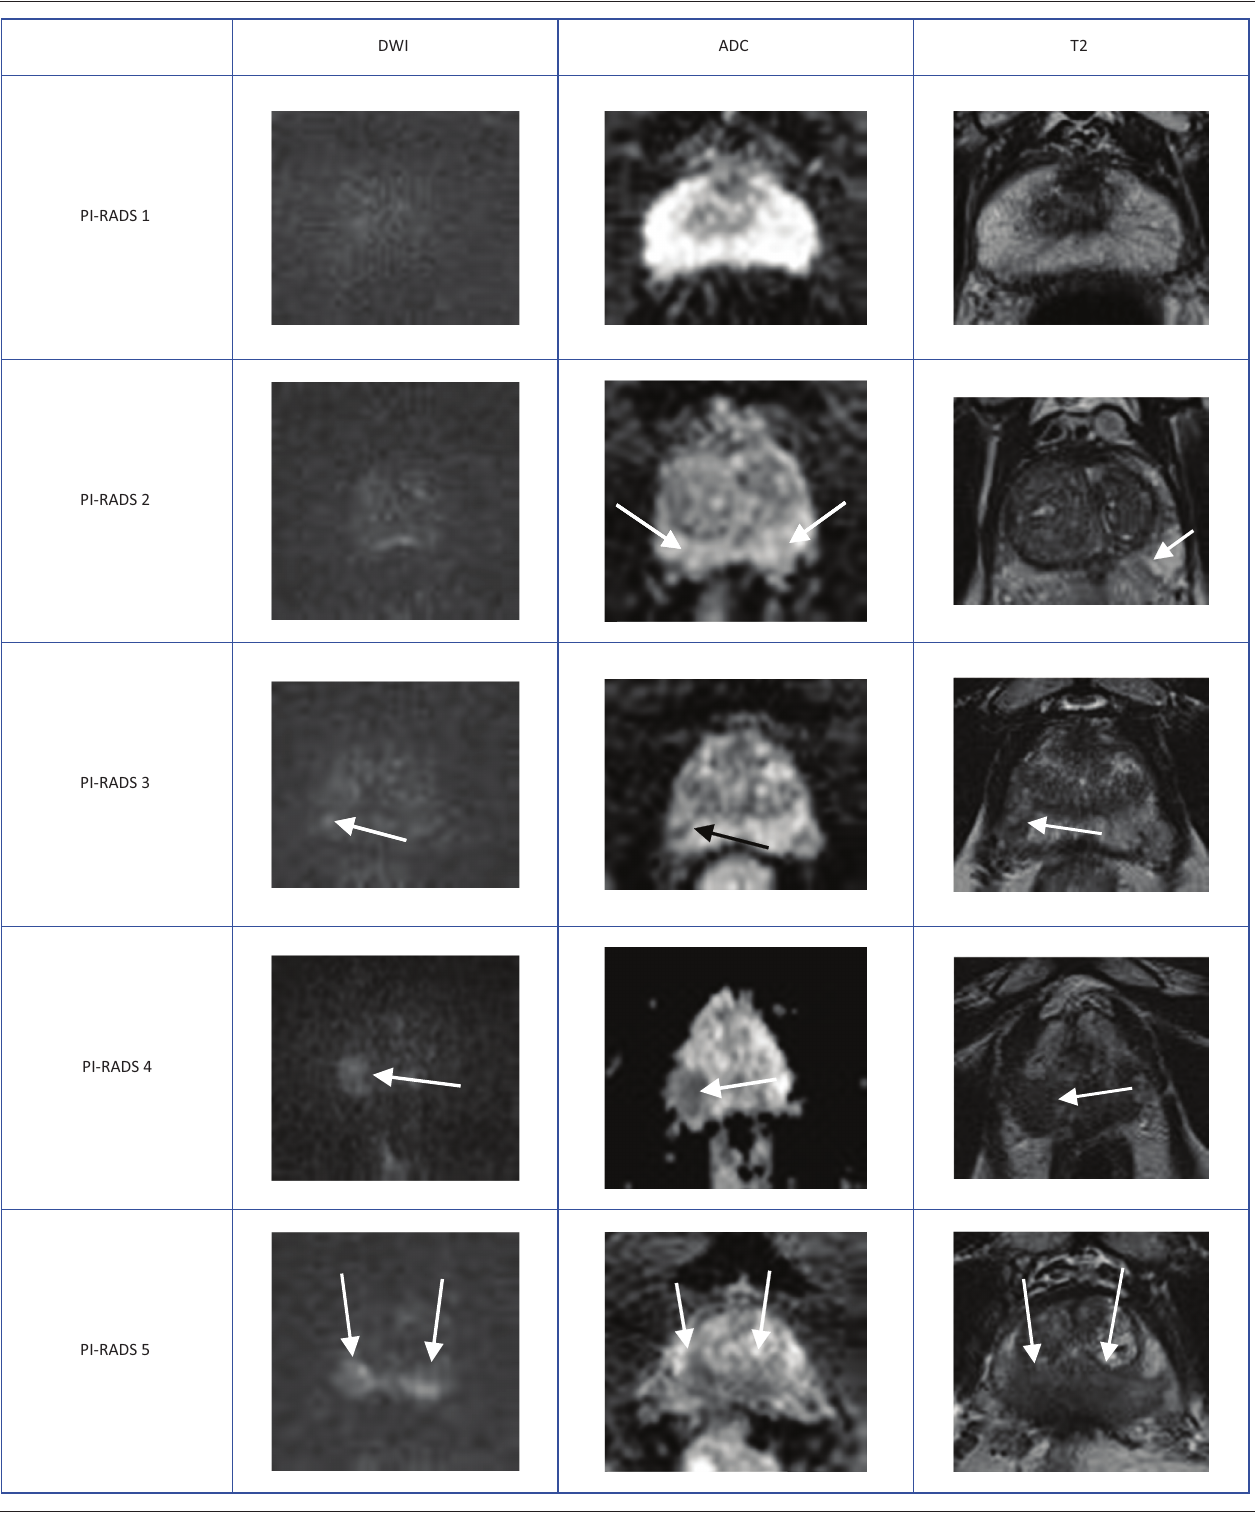
FIGURE 4: Typical peripheral zone Prostate Imaging-Reporting and Data System (PI-RADS) v2.1 lesions. Peripheral zone (PZ) shows PI-RADS assessment categories with diffusion-weighted imaging (DWI) as the dominant sequence. (1) No abnormality (normal) on all sequences. (2) Iso-intense signal of the PZ on the high b -value DW image with an indistinct linear hypointense lesion on the Apparent Diffusion Coefficient (ADC) map (arrow) with corresponding T2W linear hypointense lesion. (3) Mildly hyperintense lesion of the PZ on the high b -value DW image with focal mildly hypointense lesion on the ADC map (arrow) and hyperintense non-circumscribed lesion on the T2W image. (4) Focal markedly hyperintense lesion (arrow) on the high b -value DW image with corresponding markedly hypointense signal intensity lesion on the ADC map. Lesion size < 1.5 cm in greatest dimension. T2W image demonstrates a circumscribed, homogeneous hyperintense mass confined to the prostate. (5) Same as (4) above but size > 1.5 cm in greatest dimension and could have extra-prostatic extension/invasive